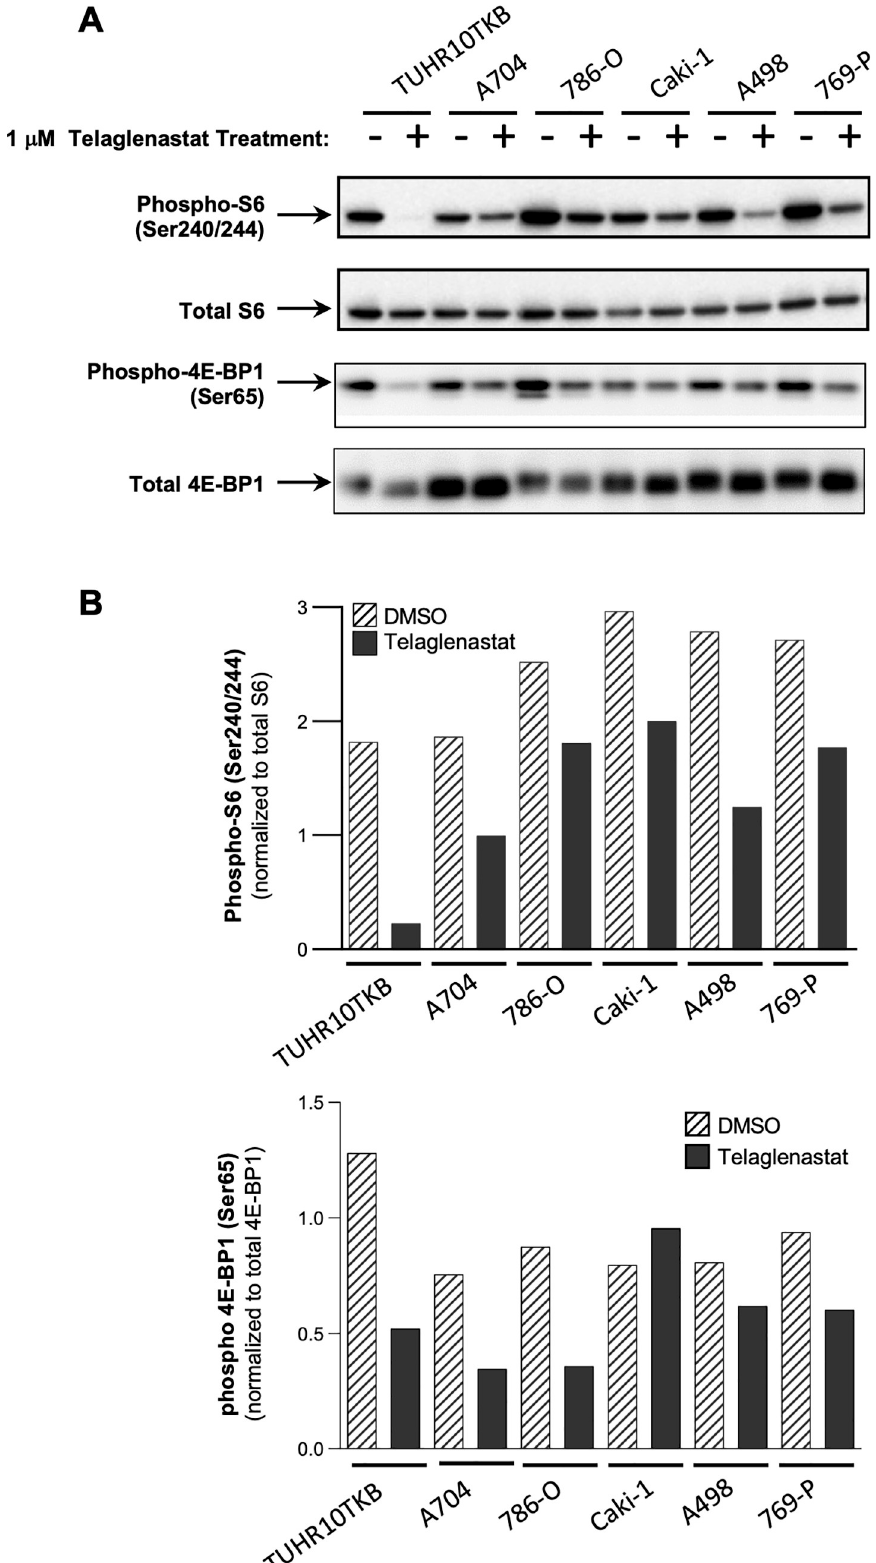
Fig 2. Telaglenastat inhibits the mTORC1 pathway in RCC cells. (A) Western blot of phospho-S6, total S6, phospho-4E-BP1 and total 4E-BP1 in RCC cell lines after 24 hours of telaglenastat treatment (1 μ M) or DMSO